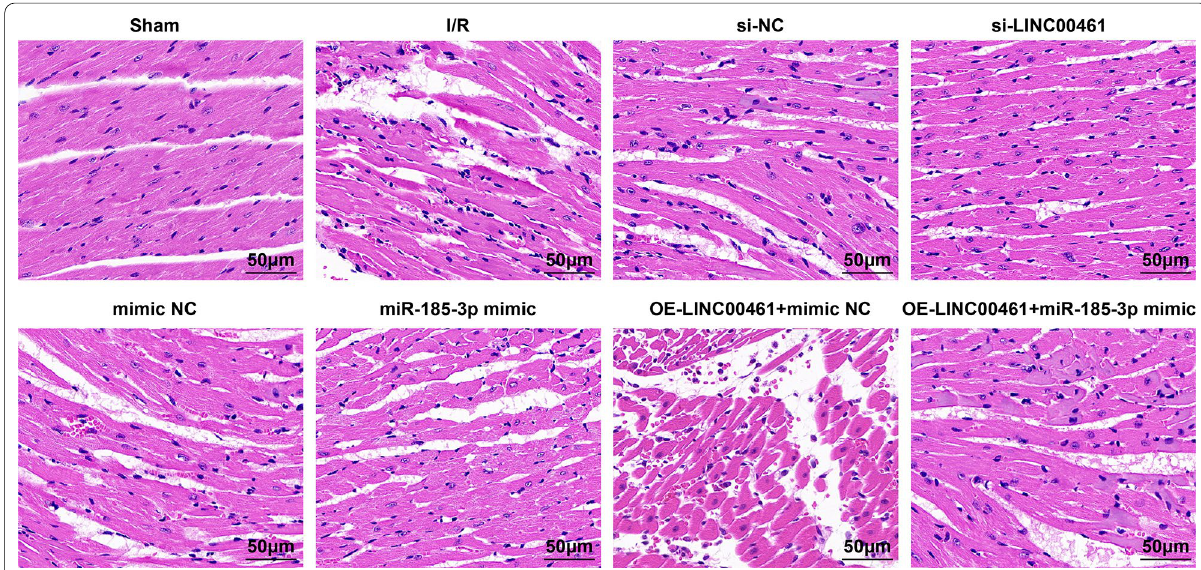
Fig. 3 Up-regulating miR-183-3p and down-regulating LINC00461 alleviate the pathological injury of I/R mice. The changes of myocardial tissue structure in each group of mice by HE